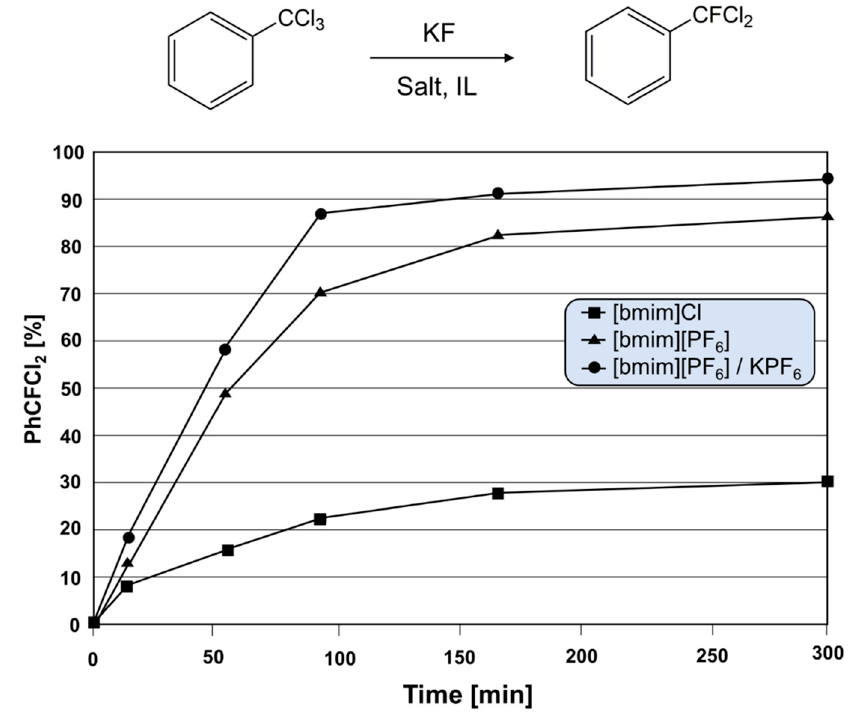
Figure 3. S N 2 fluorination of trichlorotoluene by KF in ILs.